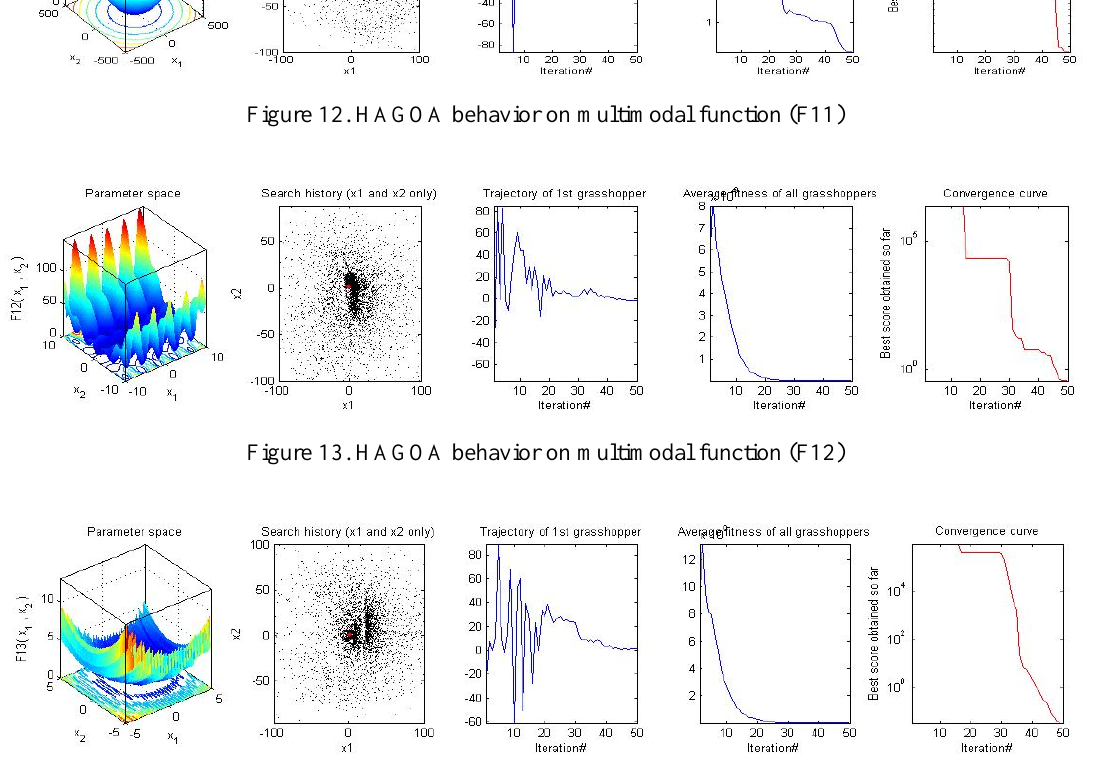
Figure 14. HAGOA behavior on multimodal function